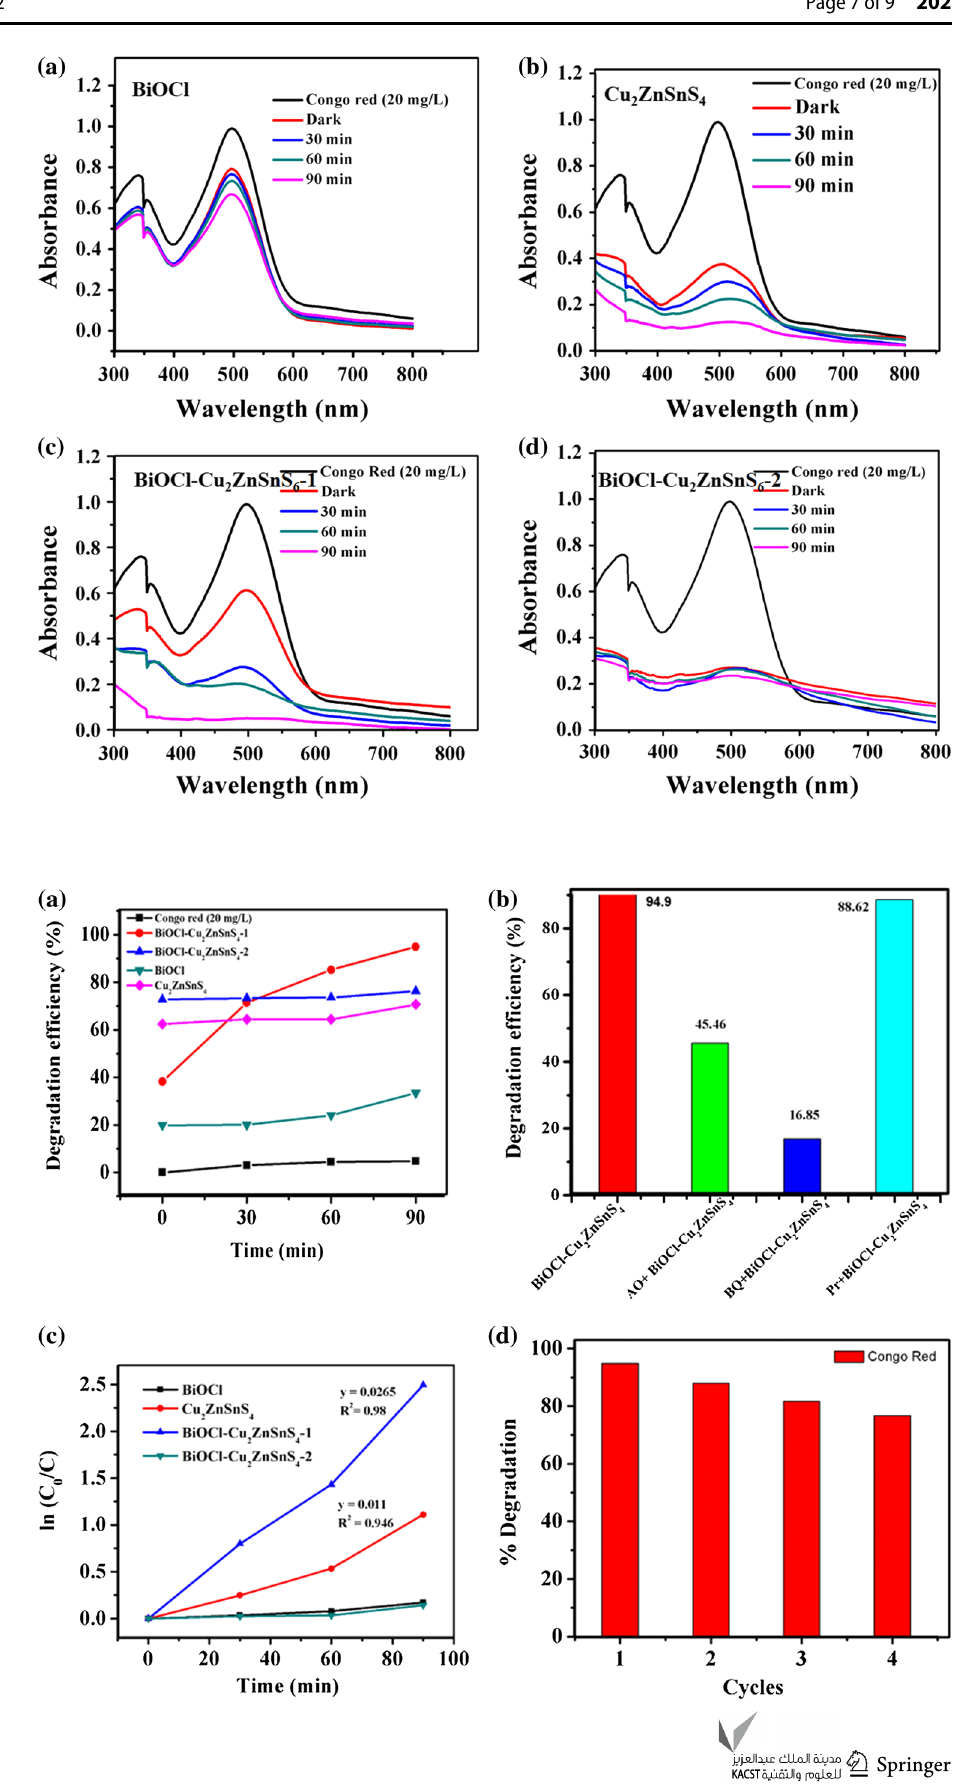
Fig. 8 UV–visible absorbance spectra of Congo red before and after solar light irradiation in the presence of a BiOCl micro- spheres, b Cu 2 ZnSnS 4 QDs, c BiOCl–Cu 2 ZnSnS 4 -1 and d BiOCl–Cu 2 ZnSnS 4 -2